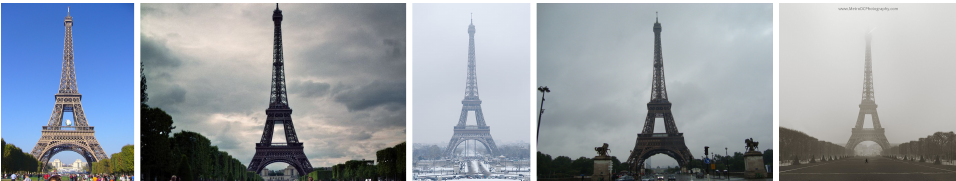
Figure 1. The Eiffel Tower in different weather conditions. Left to right: sunny, cloudy, snowy, rainy, and foggy